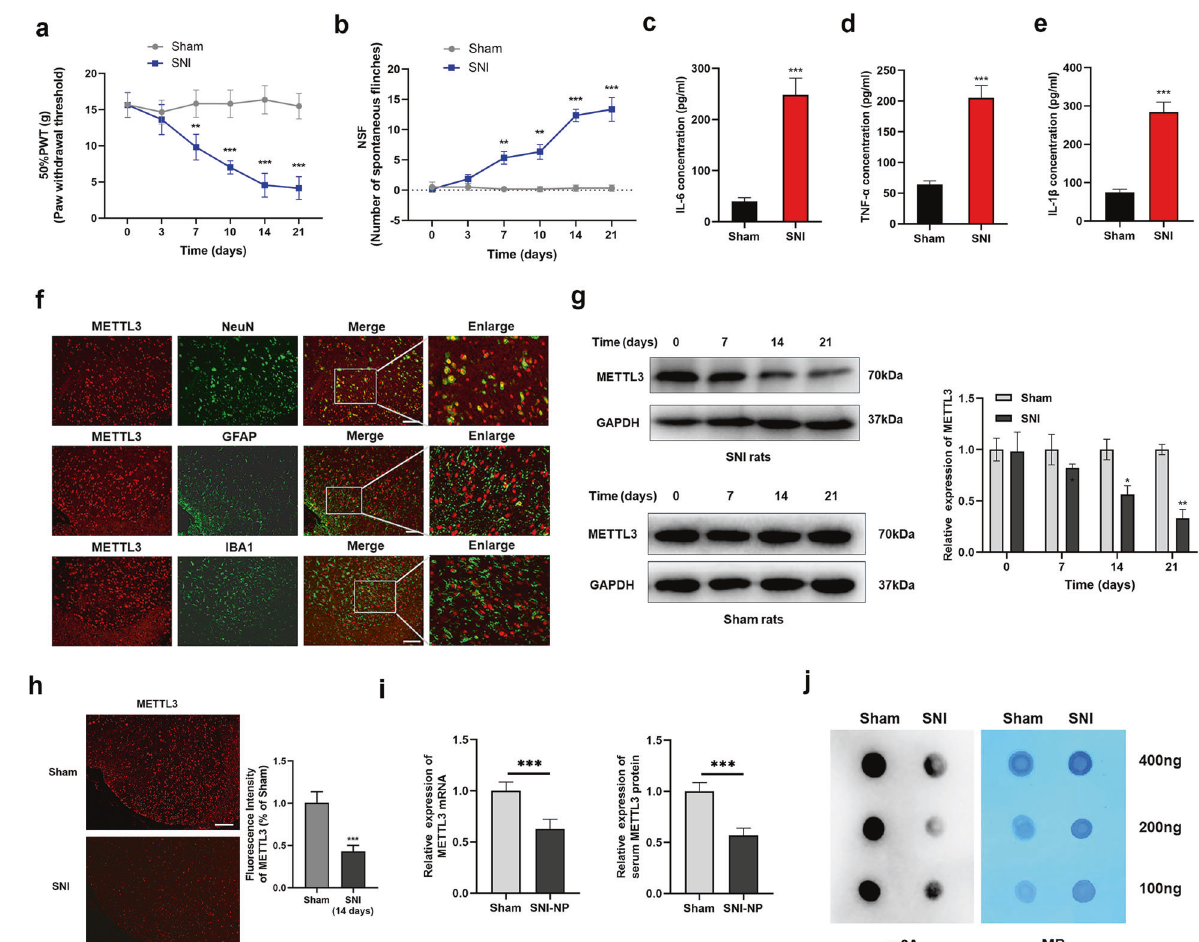
Fig. 1 METTL3 was lowly expressed in the spinal cord of established SNI-NP rats. a , b PWT ( a ) and NSF ( b ) were evaluated in the established SNI model rats and controlled sham ones. N = 5, ** P < 0.01, *** P < 0.001 compared with sham groups. c – e Neuroin fl ammatory factors, including IL-6 ( c ), TNF- α ( d ), and IL-1 β ( e ) were upregulated in spinal cord tissues of SNI-NP rats in contrast to sham ones. N = 3, *** P < 0.001 compared with sham groups. f Double- fl uorescent labeling experiment was performed with the respective antibodies to verify the tissue location of METTL3. The indications of green markers were as follows: NeuN indicates neuron, lba1 indicates microglia and GFAP indicates astrocyte. Scale bar = 100 μ m. g , h METTL3 protein was detected in experimental NP rats and sham control ones according to the results obtained from western blot ( g ) and immuno fl uorescence ( h ) at the respective time points. Scale bar = 100 μ m. * P < 0.05, ** P < 0.01, *** P < 0.001 compared with sham rats. i The transcript and protein levels of METTL3 were detected in serum of SNI-NP rats and sham rats via qPCR and ELISA (repeated triplicates). *** P < 0.001. j m6A dot-blot assays of spinal cord tissues from SNI and sham rats. Methylene blue (MB) stain as loading control. The results showed a decreased methylation of RNA in SNI rats compared with sham ones. The experiment was repeated three times with similar results. Data are presented as mean ±